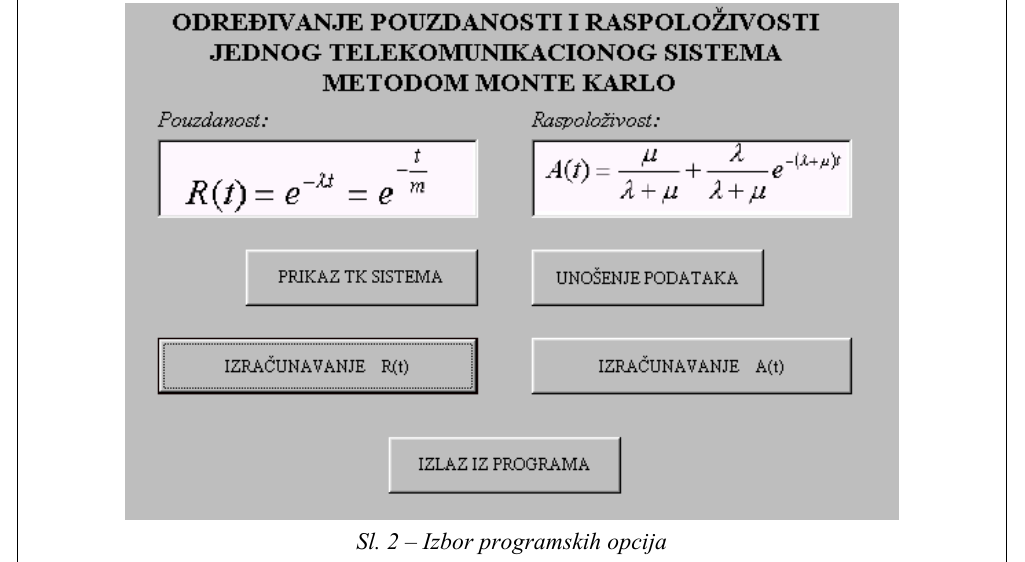
Sl. 2 (cid:150) Izbor programskih opcija lova, kako je to ve ć opisano. Proces simu- Za obe karakteristike (cid:150) pouzdanost i lacije, po metodi (cid:132)Monte Karlo(cid:147), odvija raspolo(cid:158)ivost, ukupan broj iteracija N je se po svim sastavnim delovima sistema (cid:150) isti, a broj uspe(cid:154)nih iteracija M razli č it, jer prvo za jednu karakteristiku (cid:150) pouzdanost, se u simulacioni proces ulazi sa razli č itim a zatim za drugu (cid:150) raspolo(cid:158)ivost. izrazima za vremena zastoja sastavnih de-